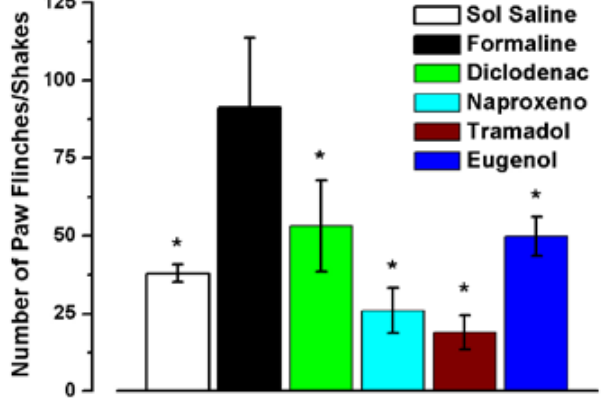
FIGURE 2 - Graphic of the phase 1 of the formalin test, the data representing Ẋ ± SEM of an n = 5. *P ≤0.05 vs. the 5% formalin group.